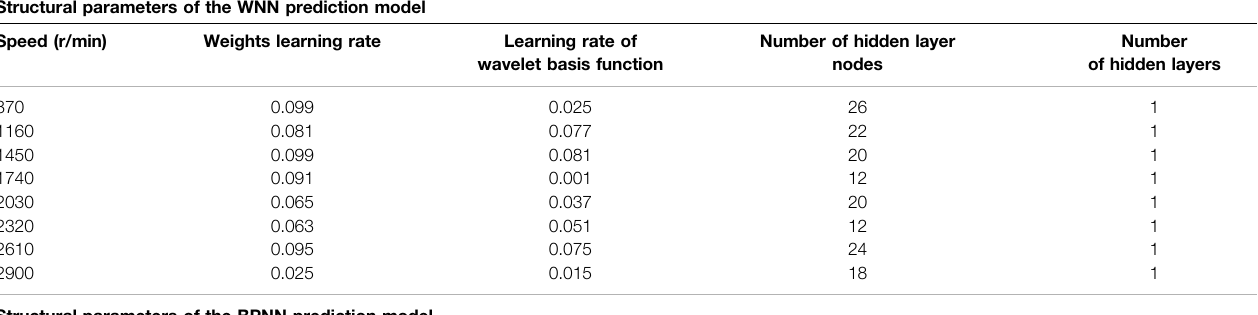
TABLE 2 | Structural parameters of the WNN prediction model and BPNN prediction model. Structural parameters of the WNN prediction model